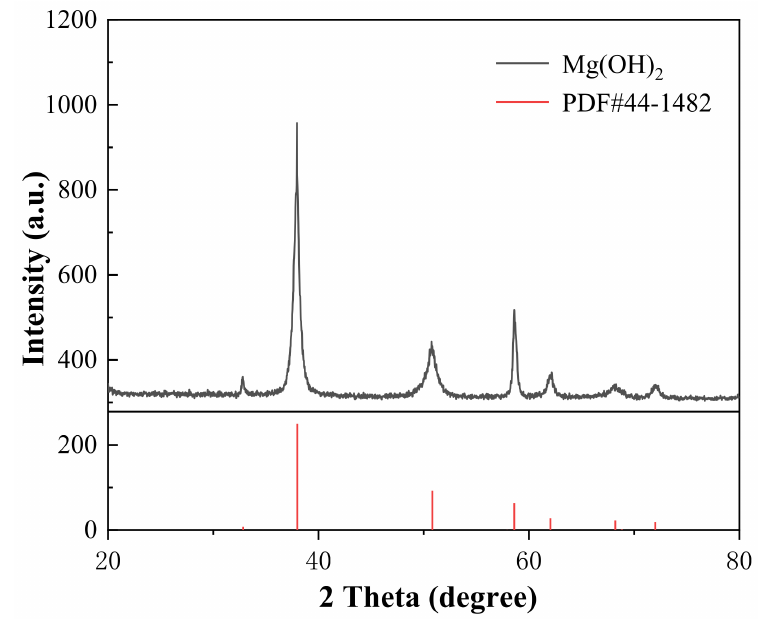
Figure 5. XRD pattern of Mg(OH) 2